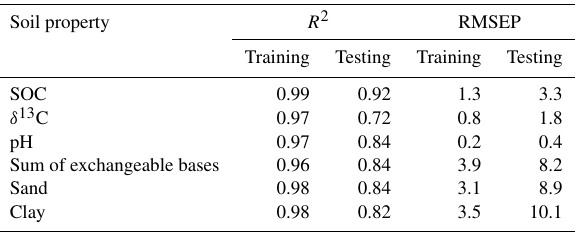
Table 1. Prediction model performance metrics for the prediction of soil properties from MIR spectroscopy included in the